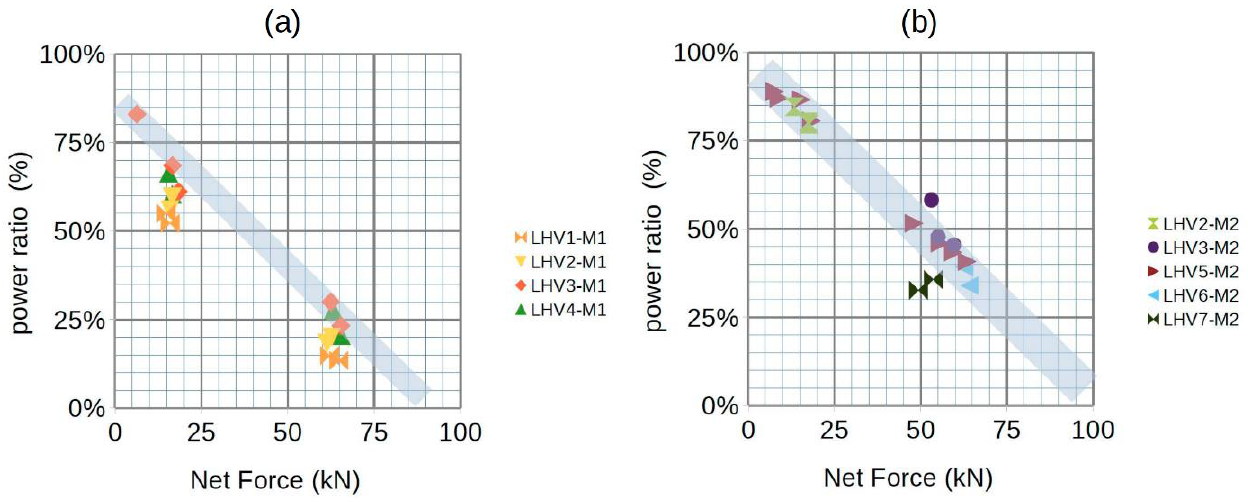
Figure 14. Comparative graphs between measured and estimated flows (Q S ) for the two machines: 14 ( a ) machine M 1 and 14 ( b ) machine M 2 .